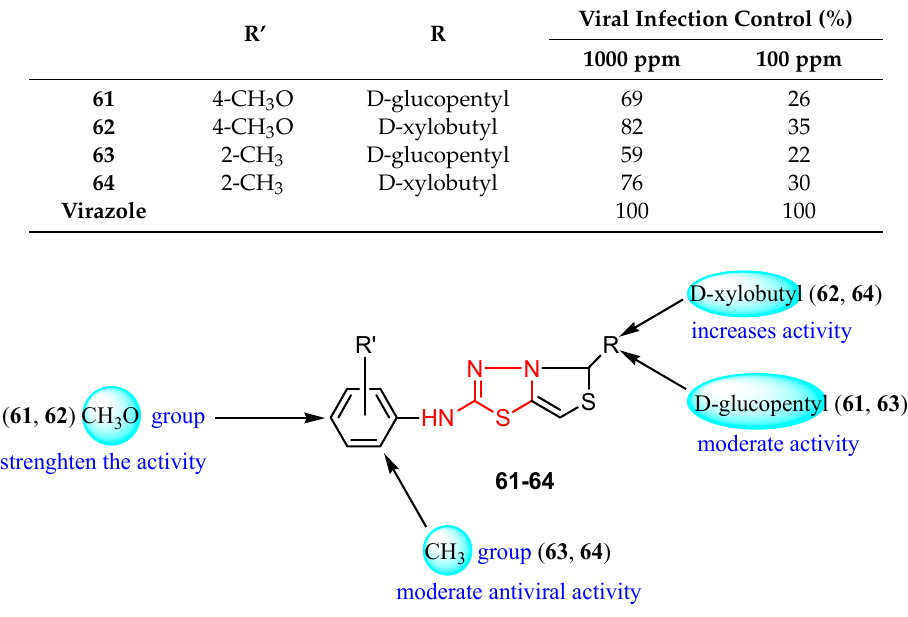
Figure 10. Influence of substituents of 1,3,4-thiadiazole derivatives 61 – 64 on antiviral activity.